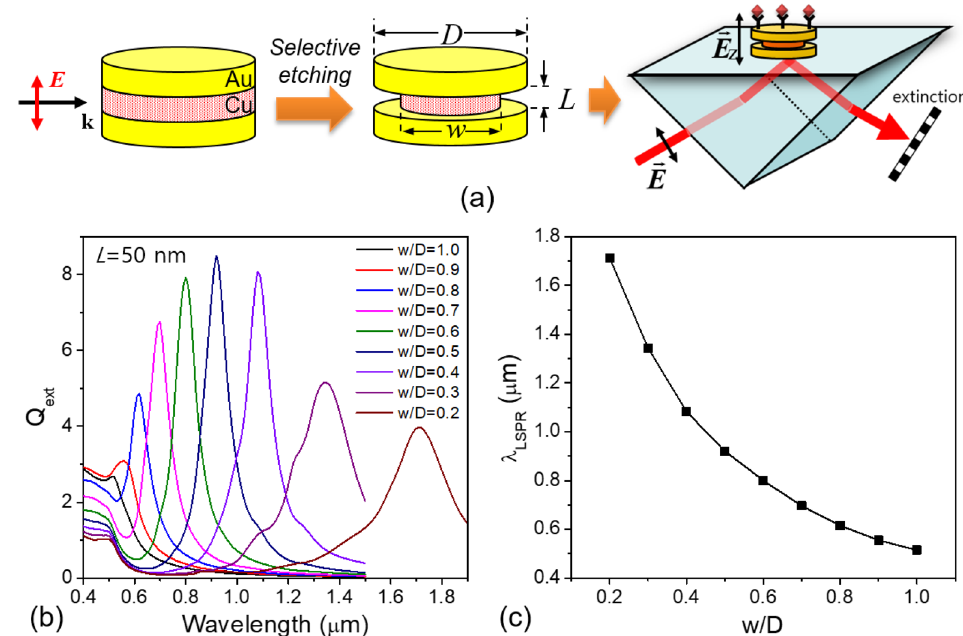
Figure 2. ( a ) Schematic of nanoplasmonic sensing platform with a vertical conductive bridge and its fabrication via selective etching process. ( b ) Spectral tunability of Au nanodiscs bridged with vertical conductive Cu junction and ( c ) the dependence of its resonance wavelength on the fractional bridge